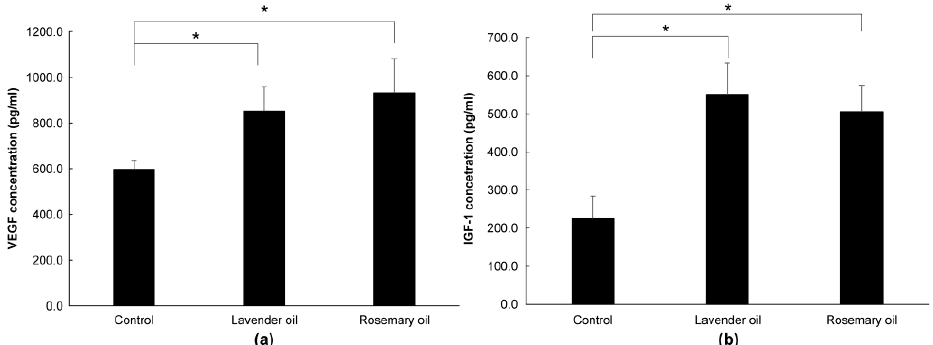
Figure 9. Upregulation of hair growth factors by lavender (0.01%) and rosemary (0.01%) oils in the 3D-Dermal papilla cell (3D-DPC) culture system. To confirm the results of the 2D-DPCs culture system, cells were treated with essential oils in the 3D-DPCs culture system. ( a ) VEGF mRNA expression was analyzed by qRT-PCR. * p < 0.01 between the essential oils-treated samples and non-treated control DPCs. ( b ) IGF-1 mRNA expression was analyzed by qRT-PCR. * p < 0.01 between the essential oils-treated samples and non-treated control DPCs.